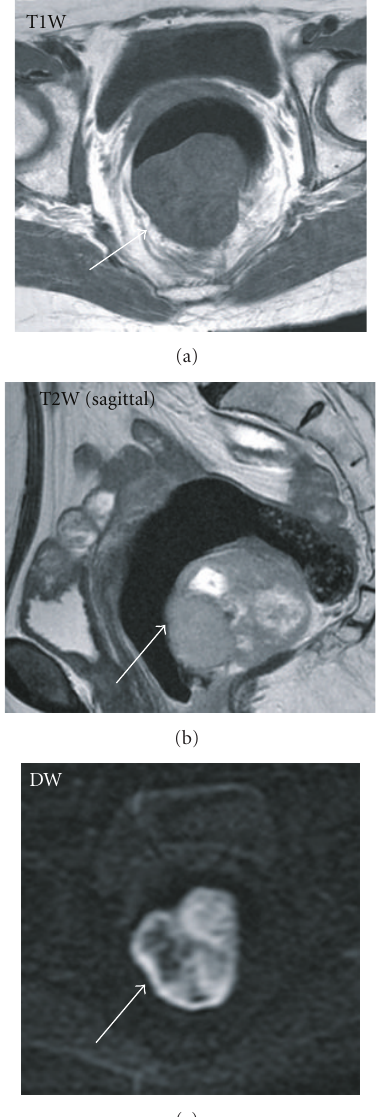
Figure 1: MRI imaging of tumor (T1-weighted (a), T2-weighted (b), and di ff usion-weighted (c) images).